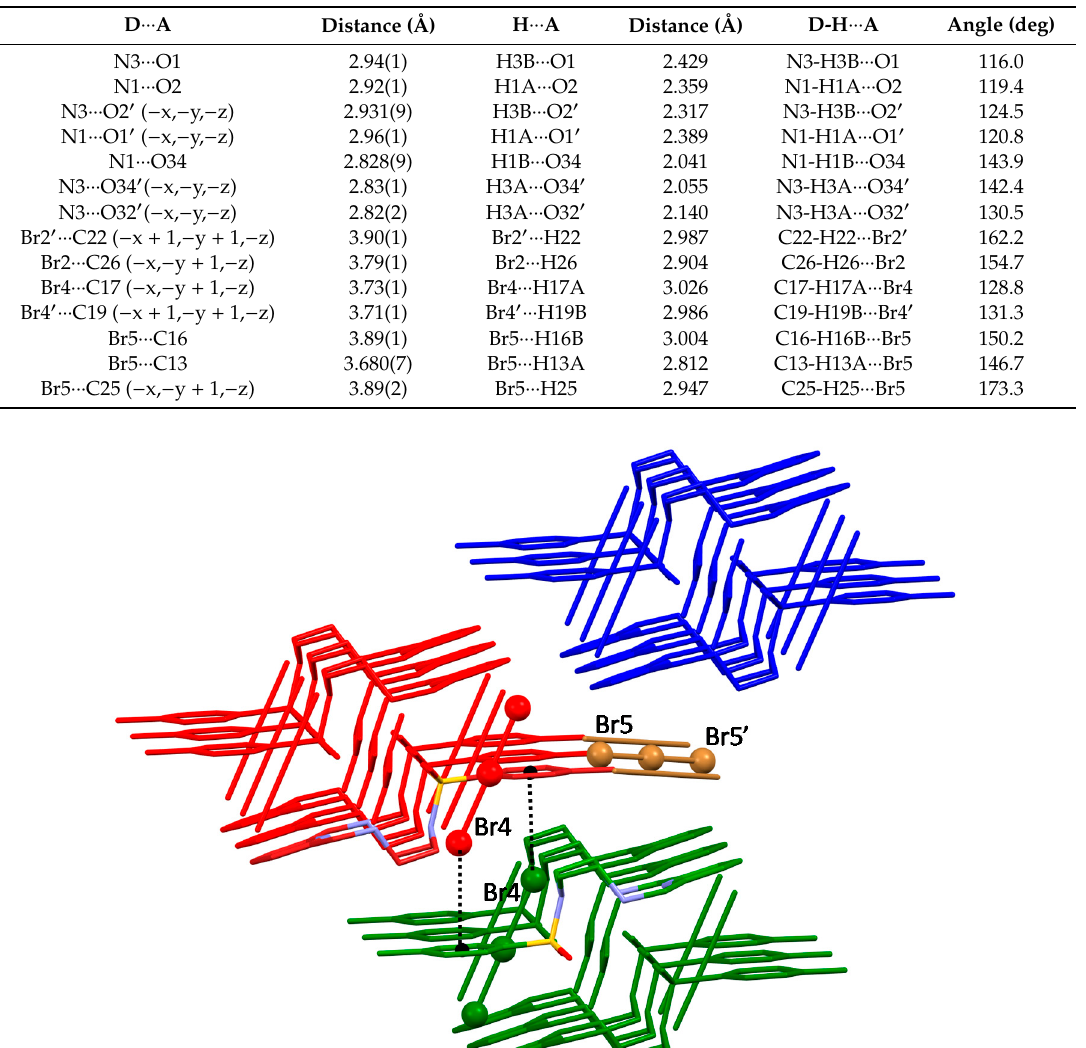
Table 1. Contacts in the crystal structure of (H 2 L-Ts)(Br 3 ) 1.5 (NO 3 ) 0.5 . Distances and angles involving hydrogen atoms in calculated positions are reported without e.s.d.